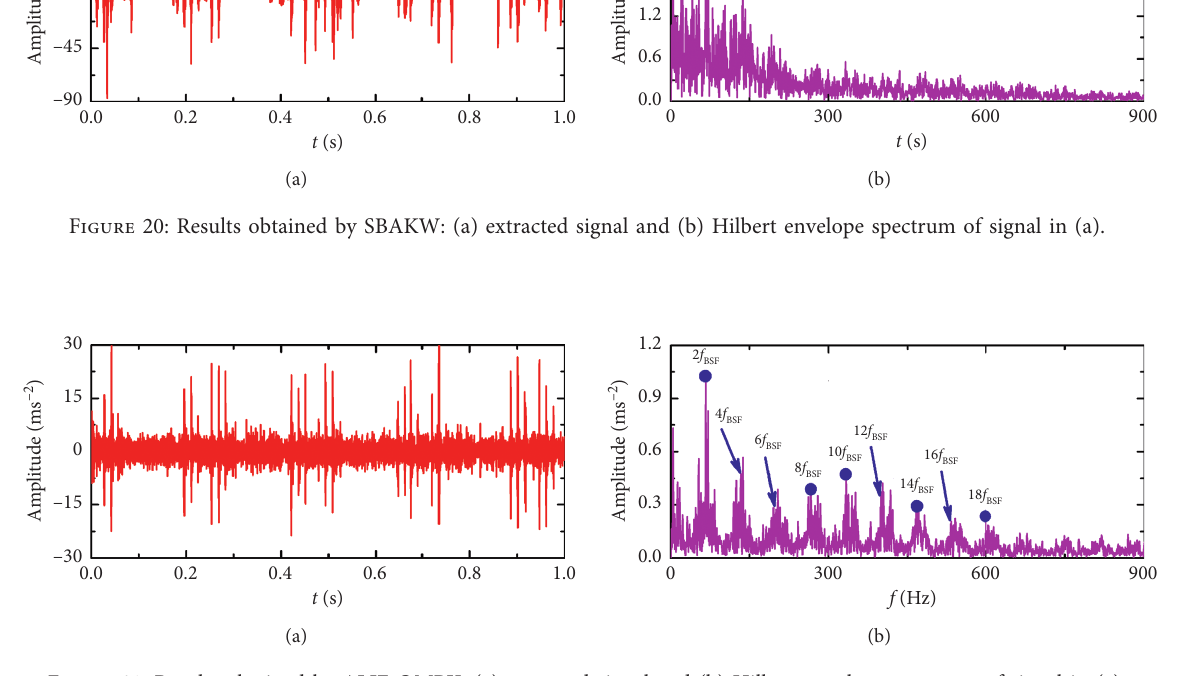
Figure 21: Results obtained by ALIF-OMPK: (a) extracted signal and (b) Hilbert envelope spectrum of signal in (a).